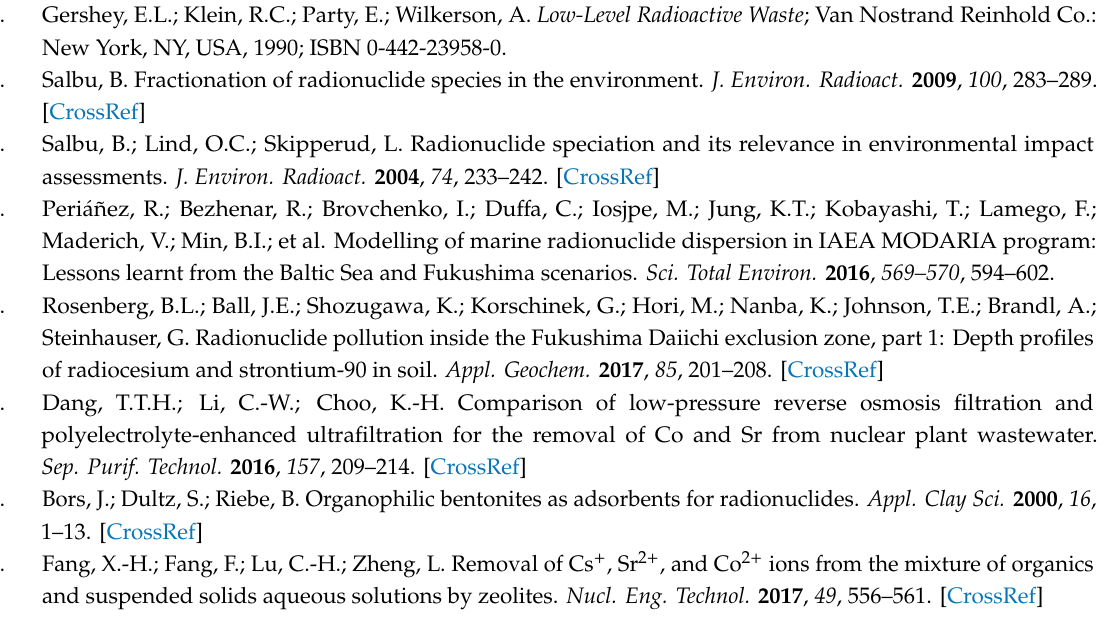
Table S1: General information about grafting agent, 3-aminopropyltriethoxysilane (APTES), Table S2: Quantitative data extracted from TG curves of LAP-APTES, with OM content the organic matter content, Figure S1: FTIR spectra of LAP and LAP-APTES synthetized with di ff erent loads of grafting agents for wavenumbers between 400 and 1600 cm − 1 (B) and between 2500 and 3700 cm − 1 (A), Figure S2: DTG curves of LAP and LAP-APTES for di ff erent loads of APTES, Figure S3: Zeta potential (ZP) of LAP, LAP-APTES-4CEC and LAP-APTES-10CEC as a function of pH, Figure S4: Single-solute adsorption isotherms of Cs + onto LAP-APTES for di ff erent loads of APTES (pH = 6–6.5), Figure S5: Competitive adsorption isotherms of Co 2 + onto LAP-APTES for di ff erent loads of APTES (pH = 6–6.5), Figure S6: Competitive adsorption isotherms of Sr 2 + onto LAP-APTES for di ff erent loads of APTES (pH = 6–6.5) and Figure S7: Competitive adsorption isotherms of Cs + onto LAP-APTES for di ff erent loads of